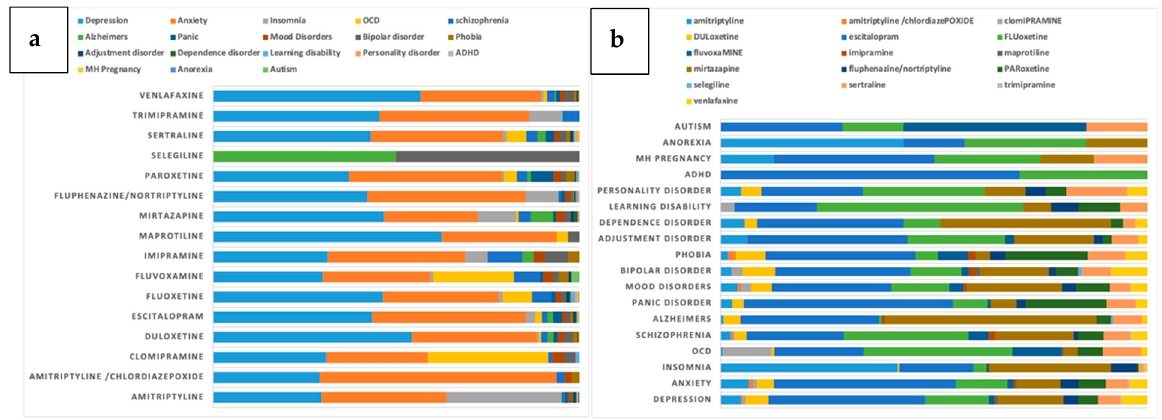
Figure 3. Use of antidepressants for the treatment of mental health disorders in the Qatari population, stratified into various categories and displayed based on ( a ) drugs, and ( b ) diagnoses. OCD: Obsessive compulsive disorder, ADHD: Attention-deficit hyperactivity